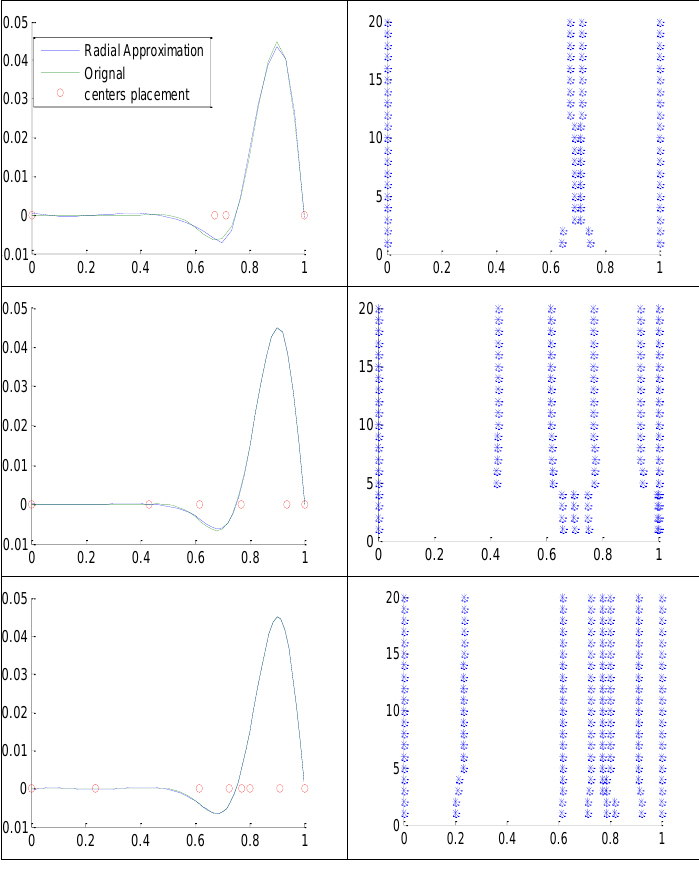
Figure 3. Radial basis approximation and evolution of final centers’ placement for the function f 2 ( x ) with 2, 4 and 6 interior centers, respectively. Table 2. Two approximation discretization errors for f 2 ( x )